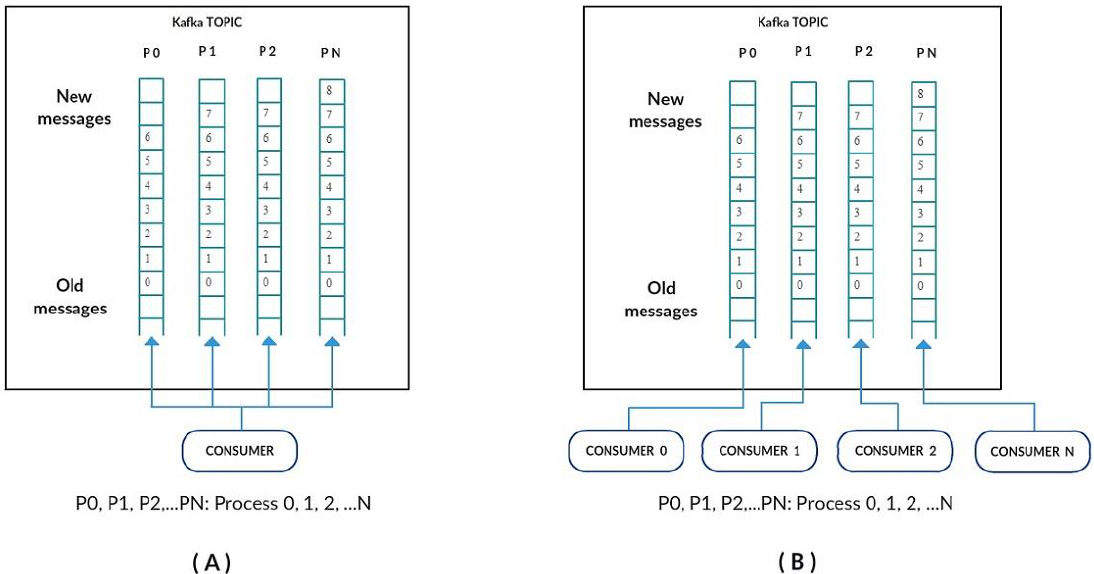
Figure 8. Kafka Consumer Configuration. In ( A ), a Kafka consumer reads all data partitions (P0, P1, P2, ... PN) as data arrive and this sole consumer limits the overall capacity even considering the existence of parallel partitions to manage the volume of data coming from a large network of devices under the control of an IoT middleware, while in ( B ), multiple Kafka consumers operate each one dedicated to reading its specific data partition only, thus leveraging the parallelism in partition